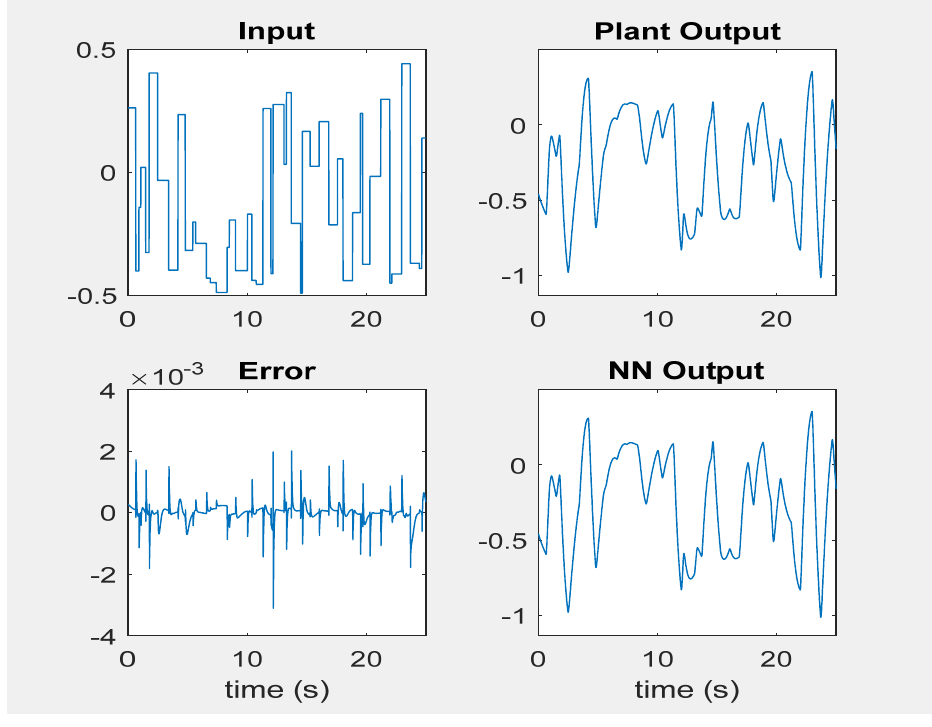
Figure 9. Validation data of neural network.